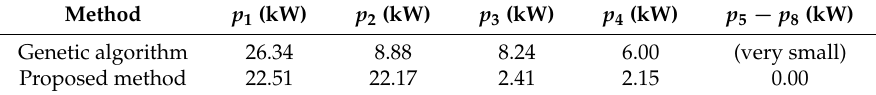
Table 6. Results obtained using genetic algorithm and the proposed method.